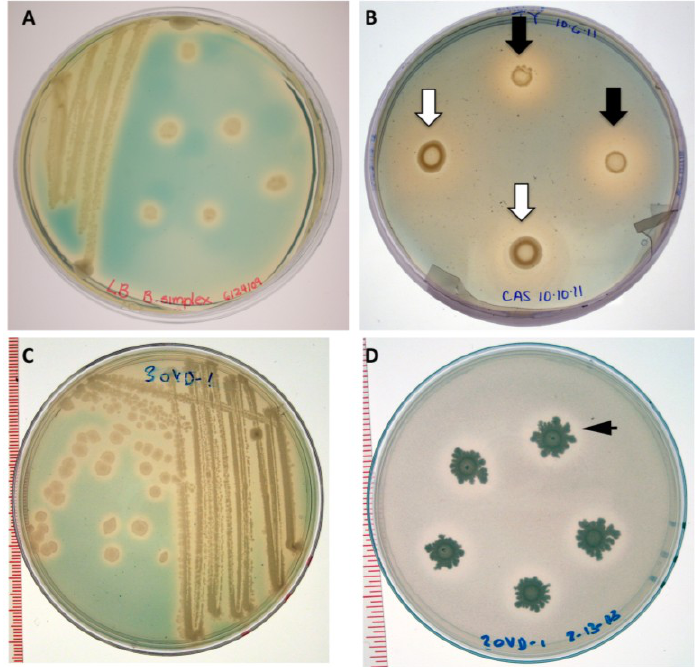
Figure A2. Iron-binding ( A – C ) and phosphate solubilization assays; ( A ) B. simplex grown on LB with Chrome Azurol S overlay; ( B ) Similar to A , but TY medium was used, the black arrows indicate B. simplex whereas the white arrows indicate B. subtilis BAL218, the halos indicate siderophore production; ( C ) CAS assay for B. subtilis 30VD-1; ( D ) B. subtilis 30VD-1 is able to degrade rock phosphate; The arrow delimits the edge of the phosphate-solubilization